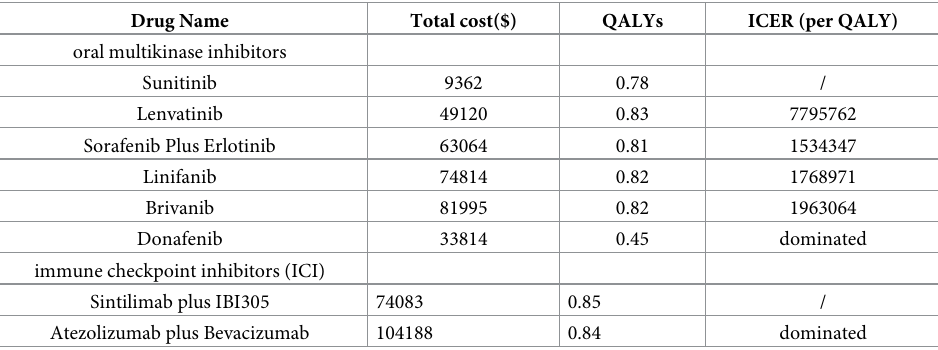
Table 3. Results of oral multikinase inhibitor group and ICI